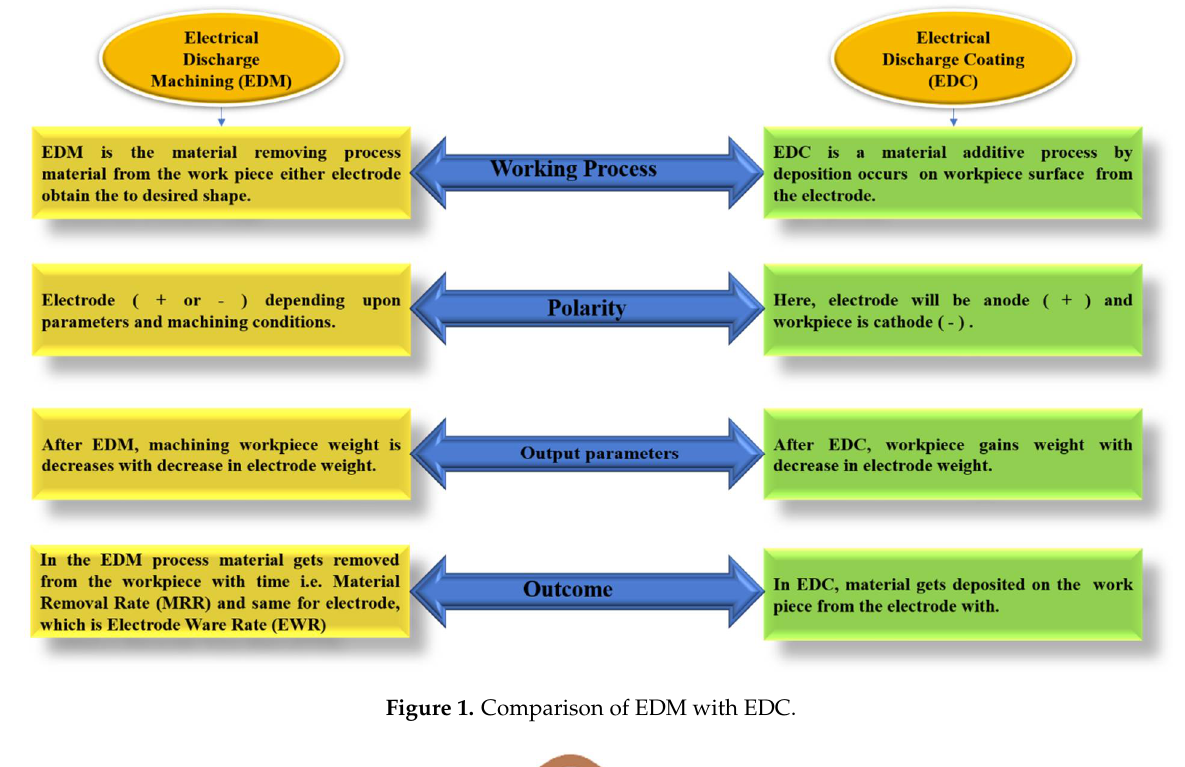
Figure 1. Comparison of EDM with EDC.